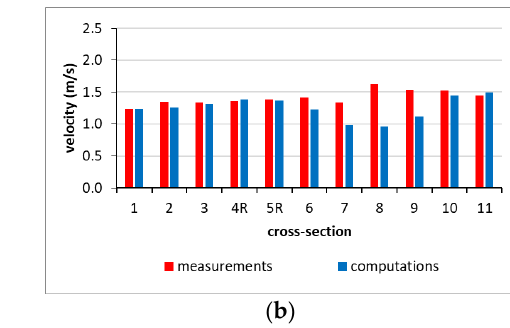
Figure 8. Graphical illustration of the model validation example: ( a ) water surface profile for Q 5% , ( b ) estimations of mean velocities for Q 5% . Table 7. Final results of model validation calculated for cross-sections where the flow was one-dimensional (p-1, p-2, and from p-7 to p-11, as shown in Figure 5a). Type of Experiment